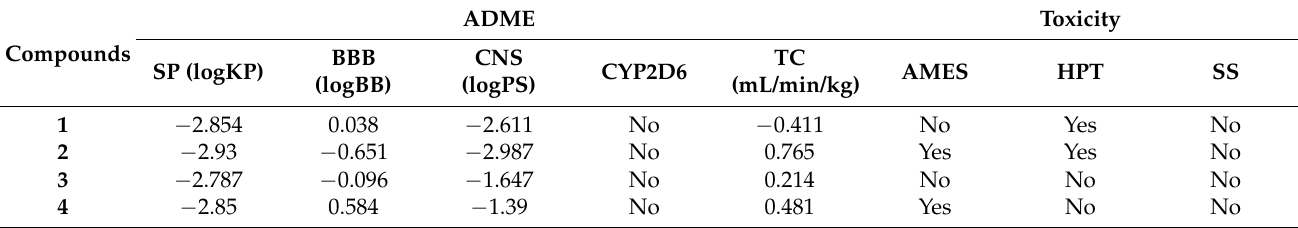
Table 4. ADMET Prediction